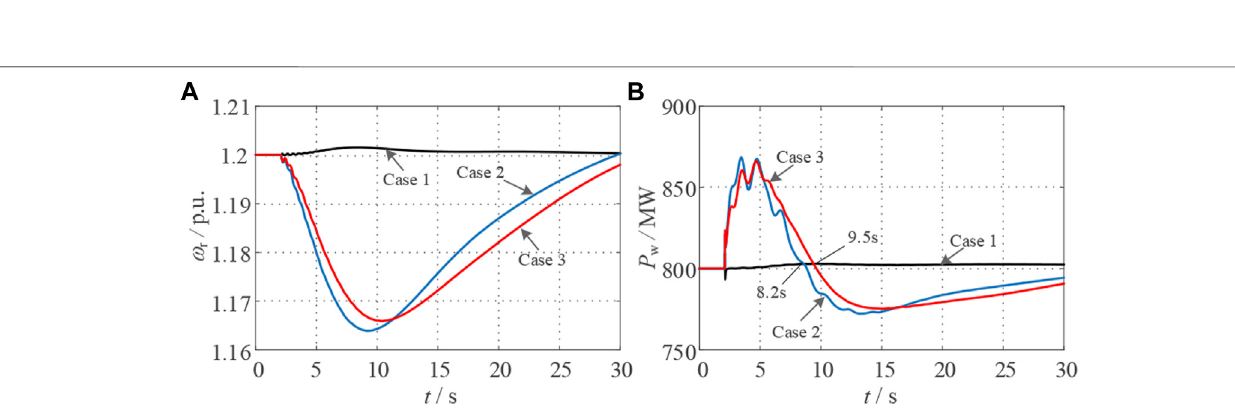
FIGURE11|(A) showsthechangecurveoftherotationalspeedofthewindturbineafterasuddenloadincrease,and (B) showstheoutputpowercurveofthewind turbine.